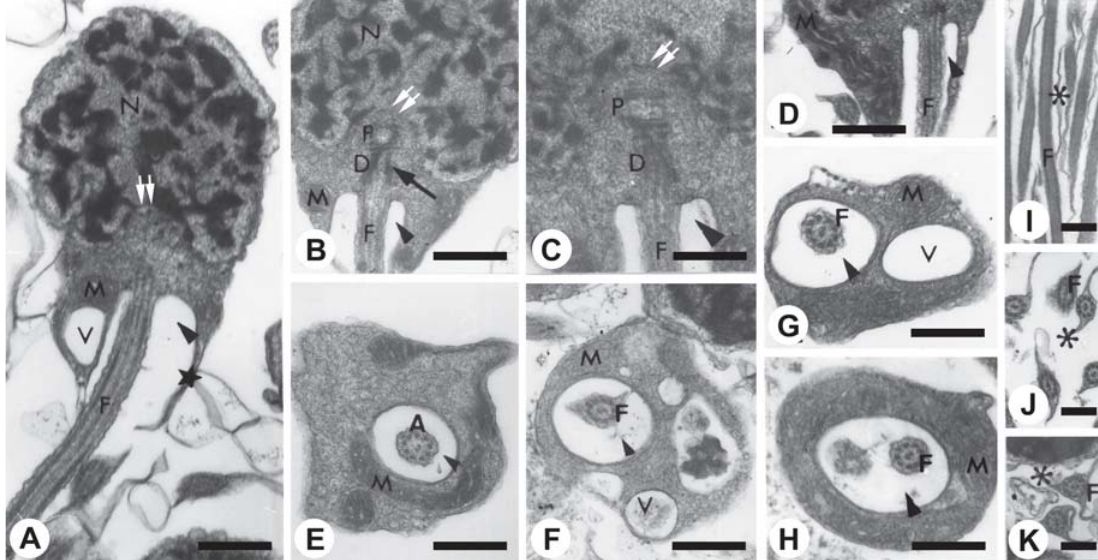
Fig. 4. Mylossoma duriventre spermatozoa. A - Spermatozoa in longitudinal section. B and C - Longitudinal sections of the nuclear fossa region. D - Midpiece in longitudinal section. E to H - Midpiece in cross sections. I - Flagellum in longitudinal section. J and K - Flagella in cross sections. Scale bars, A = 0.55 µ m; B = 0.6 µ m; C = 0.35 µ m; D = 0.6 µ m; E - F = 0.45 µ m; G = 0.35 µ m; H = 0.4 µ m; I = 0.5 µ m; J = 0.3 µ m; K = 0.25 µ m. A: axoneme; D: distal centriole; F: flagellum; M: mitochondria; N: nucleus; P: proximal centriole; V: vesicle; Asterisk: fins; Arrow: electron dense material; Arrowhead: cytoplasmic canal; Double arrow: nuclear fossa; Star: cytoplasmic